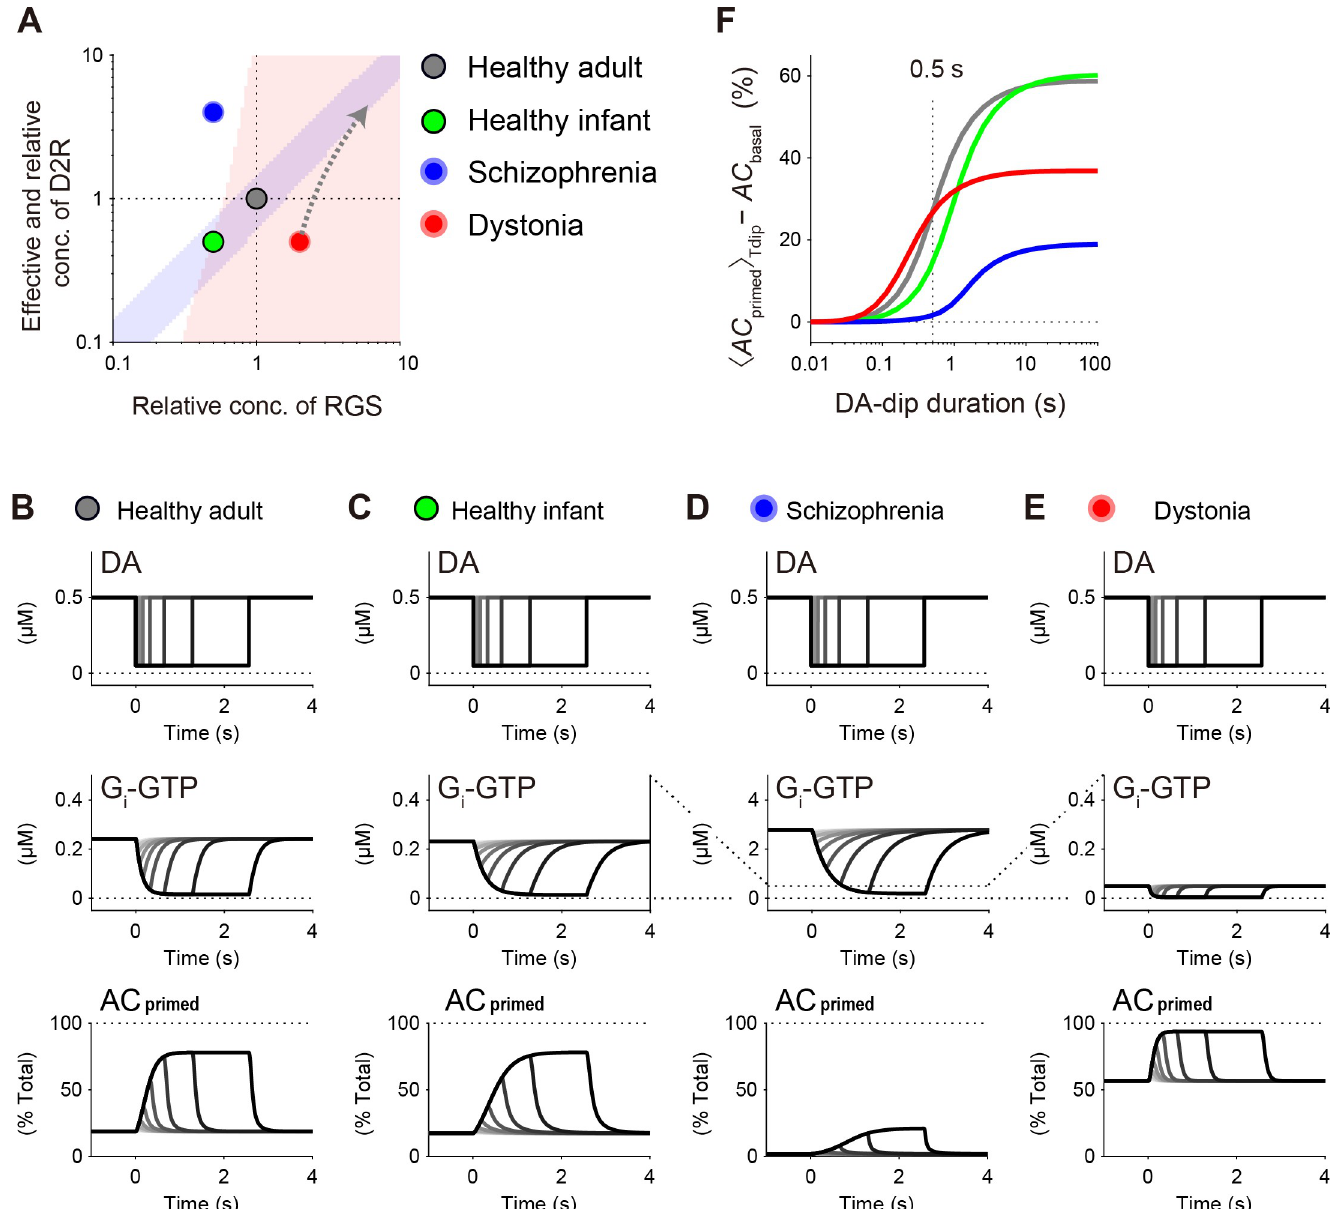
Fig 6. DA dip is undetectable under the pathologic imbalance between D2R and RGS. (A) Levels of D2R and RGS under healthy and pathologic conditions. Healthy infant mice show lower levels of D2R and RGS (green circle) than healthy adult mice do (standard model; gray circle, see Fig 2D) [28]. Schizophrenia patients are known to show higher and lower activities of D2R and RGS, respectively (blue circle) [29,31,32], and a mouse model of DYT1 dystonia shows the opposite changes in their levels (red circle, Fig 2D) [28]. Gray arrow denotes the hypothetical trajectory of changes in RGS and D2R levels if the levels of RGS and D2R are increased from the dystonic levels by the same ratio as in the increasing ratio under the development of healthy mice, i.e., ([ D2R ], [ RGS ]) = μ × ([ D2R ] tot , [ RGS ] tot ) + ([ D2R ] Dystonia , [ RGS ] Dystonia ) where [ D2R ] Dystonia and [ RGS ] Dystonia are the dystonic levels of D2R and RGS, and μ is the constant ( > 0; see Discussion). (B–E) Dynamics of [ G ] and AC primed against DA dips with a variety of durations (0.01 s, 0.02 s, ... , 2.56 s). (F) Summary of the DA-dip duration dependences i -GTP quantified using < AC primed > Tdip − AC basal (see